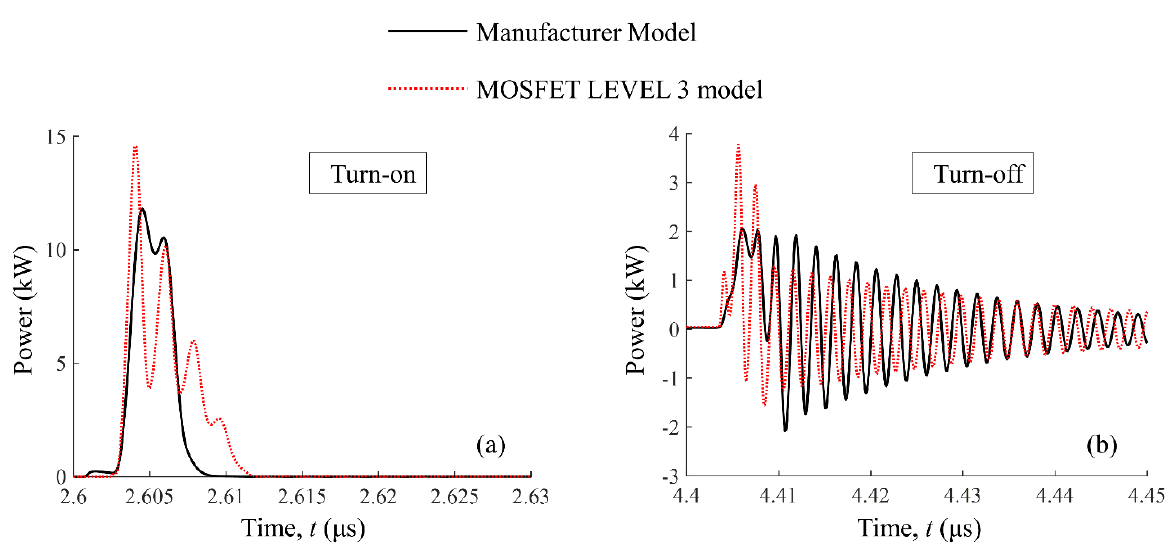
Figure 9. Simulated power comparison between manufacturer model and the MOSFET LEVEL 3 model during ( a ) turn-on interval and ( b ) turn-off interval.